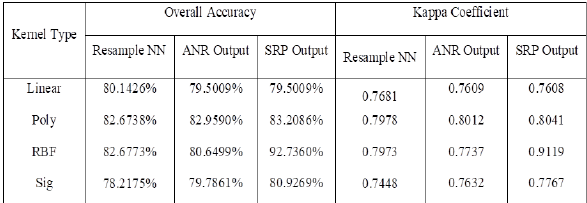
Table 1. OA and Kappa Statistics for Different Types of SVM